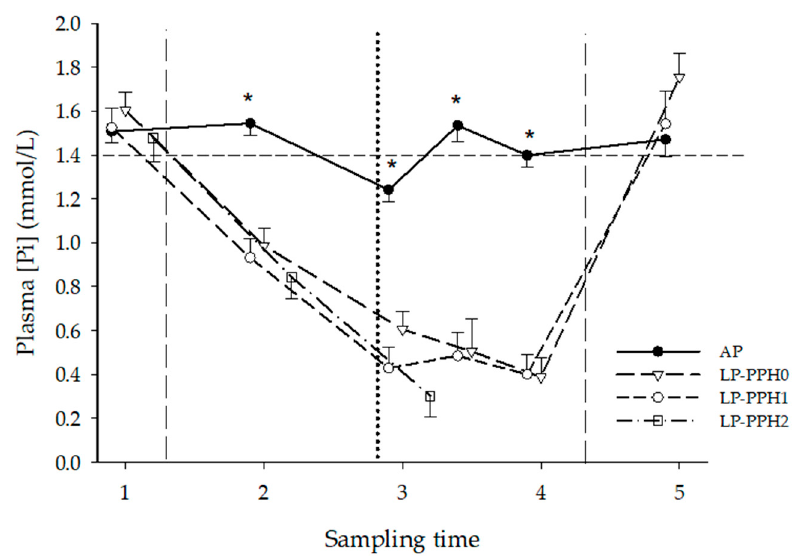
Figure 2. Plasma Pi concentration of dairy cattle receiving either a diet with adequate P content (AP, n = 18) or a P deficient diet (LP, n = 18) in the periparturient period. LP-PPH2: cows that developed clinical PPH (i.e., hemoglobinuria; n = 5), LP-PPH1: cows with subclinical PPH (n = 6); LP-PPH0: cows without evidence for PPH (n = 7). The vertical dashed lines mark the beginning and end of the phosphate depletion and repletion phase of the study. The vertical dotted line indicates calving. The horizontal dashed line presents the lower limit of the reference range for Plasma Pi in cattle. * means different from all other groups at that